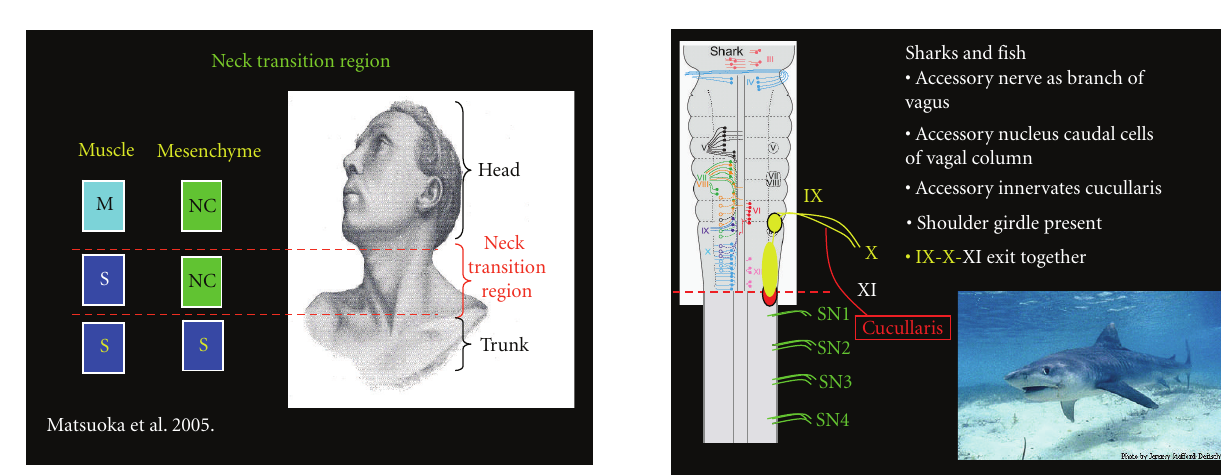
Figure 4: The neck region is a unique region recently highlighted by Matsuoka et al. [53]. The striated muscle in the neck is formed from somites, while the connective tissue and osseous attachment are derived from neural crest cells. Thus, the neck has components of both head and trunk and can be viewed as a transition between the two.